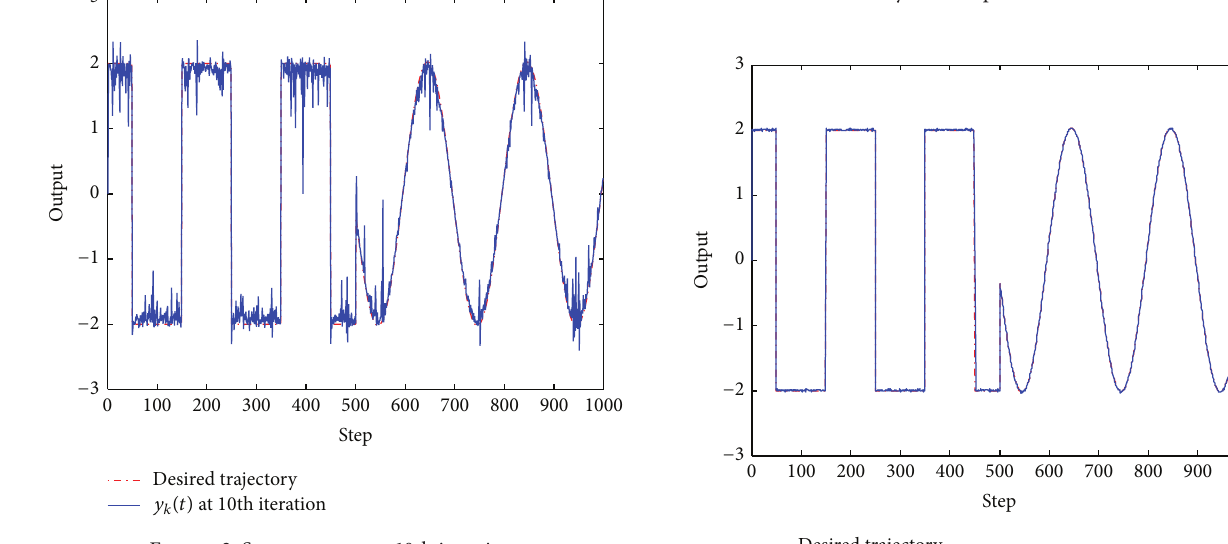
Figure 2: System output at 10th iteration.